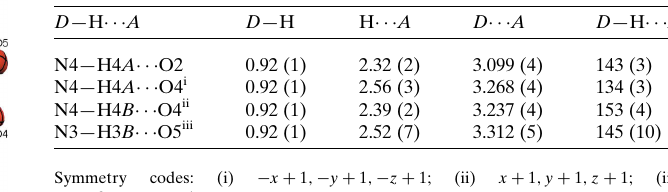
Table 1 Hydrogen-bond geometry (A˚ , (cid:5) ).